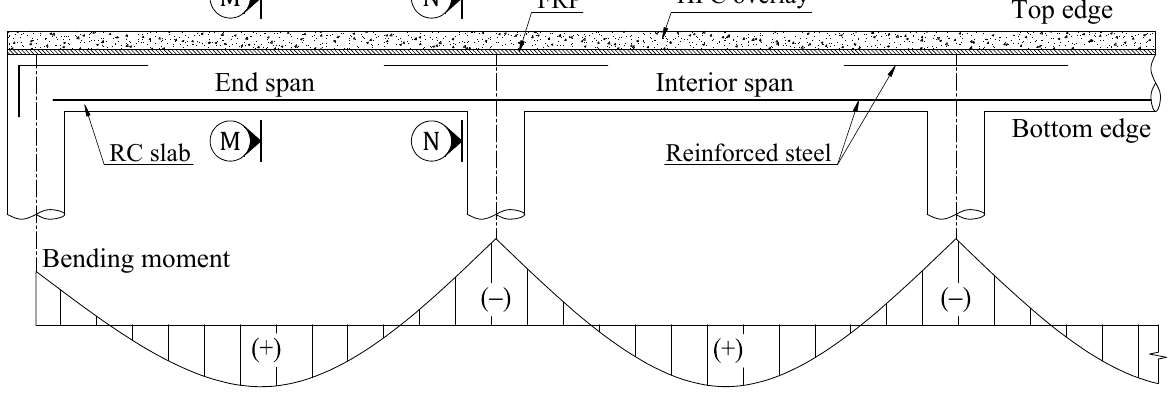
Figure 1. An innovative HPC-FRP hybrid retrofit system for strengthening continuous RC slab.